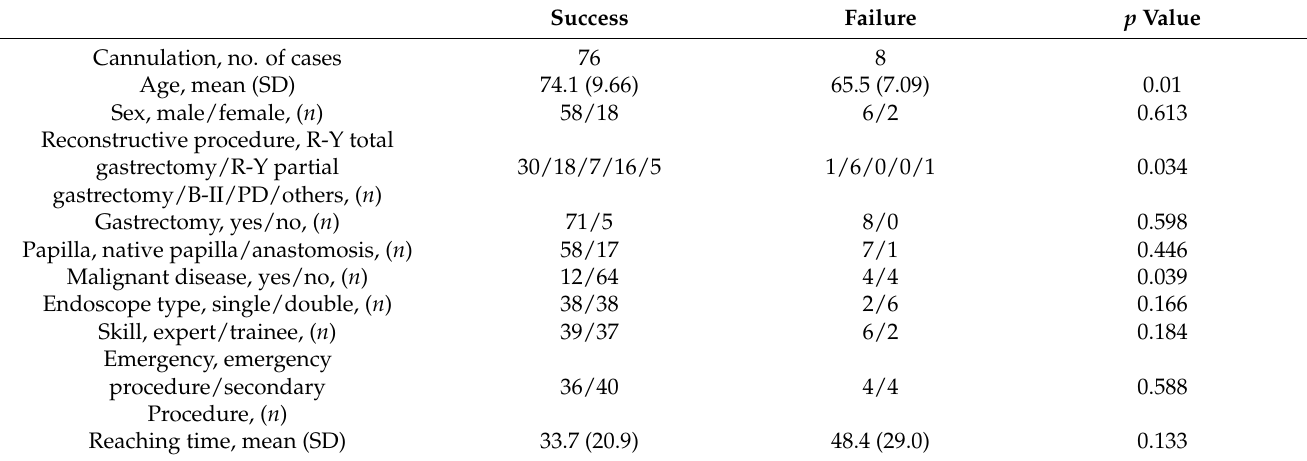
Table 3. Association of each factor with success and failure in patients undergoing